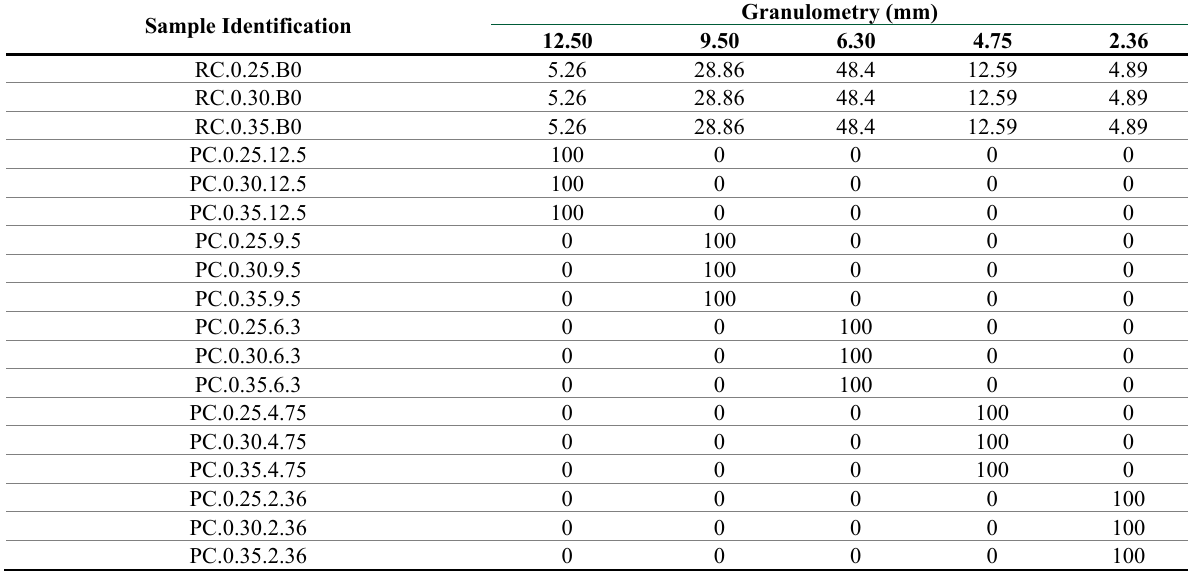
Table 3 S ample granulometry, in